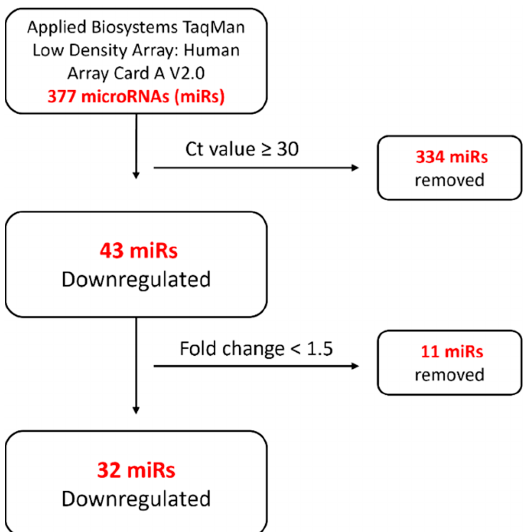
Figure 1. ENG siRNA ( ENG ) effectively depleted ENG protein in HUVECs compared with that in negative control siRNAs (CON) and non-transfected controls (—) shown via Western blot analysis (upper panel). Bar graph represents relative ENG protein levels (lower panel). **** p < 0.0001, ns: not significant ( p = 0.979).